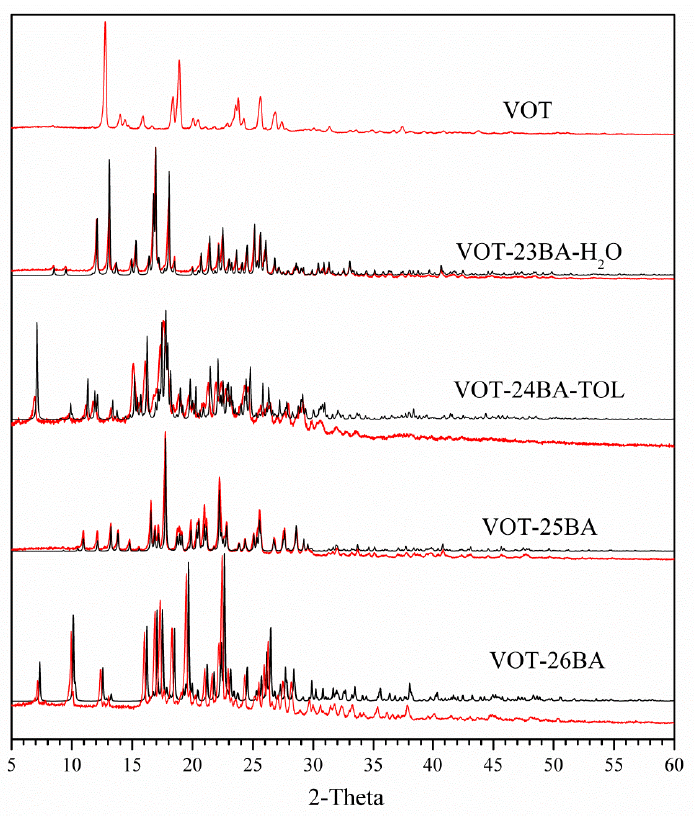
Figure 5. Experimental (red) and simulated (black) powder X-ray di ff raction (PXRD) patterns for VOT, VOT-23BA-H 2 O, VOT-24BA-TOL, VOT-25BA, and VOT-26BA salts.